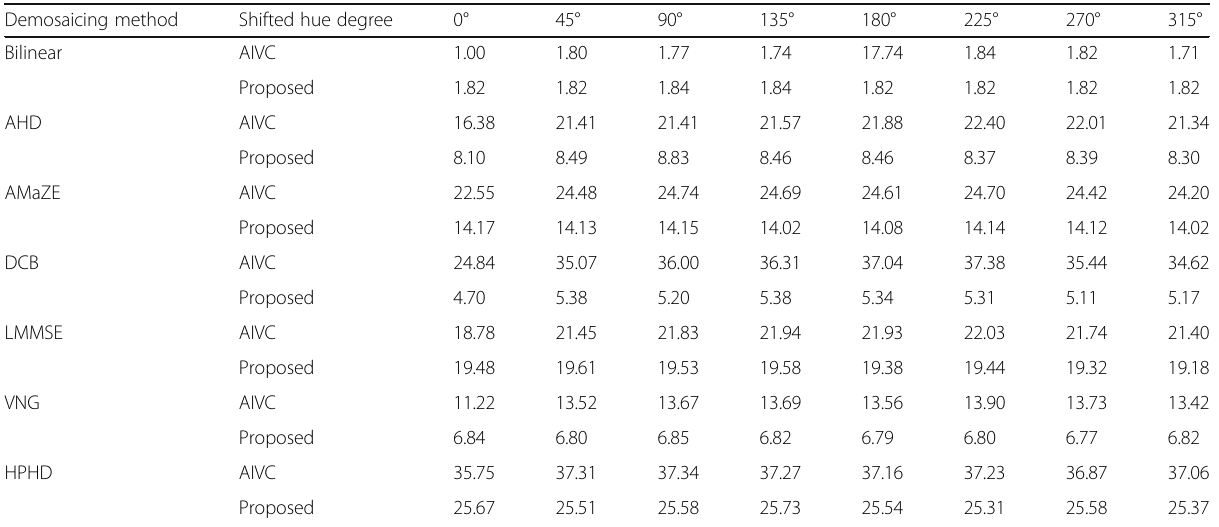
Table 5 Mean error value comparisons between our method and the AIVC algorithm for various hue shift angles Demosaicing method Shifted hue degree